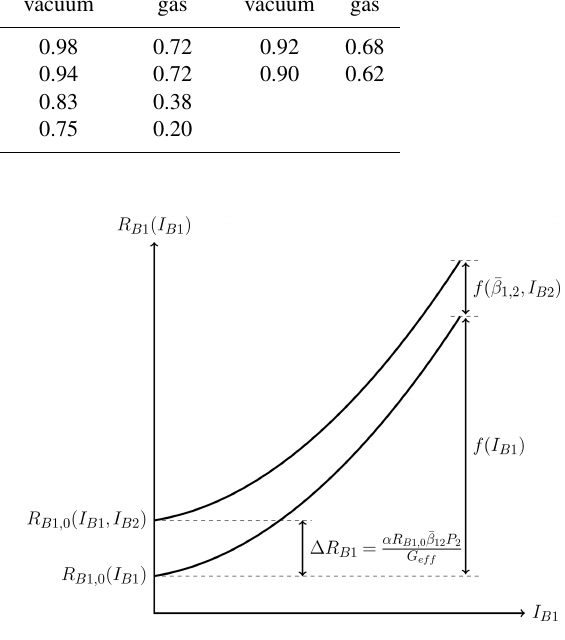
Figure 5. Effect on the resistance in terms of the current stimuli. The bottom graph represents the reference curve when biasing the first resistive element alone, while the top graph shows the addi- tional increased resistance when the second resistor is also